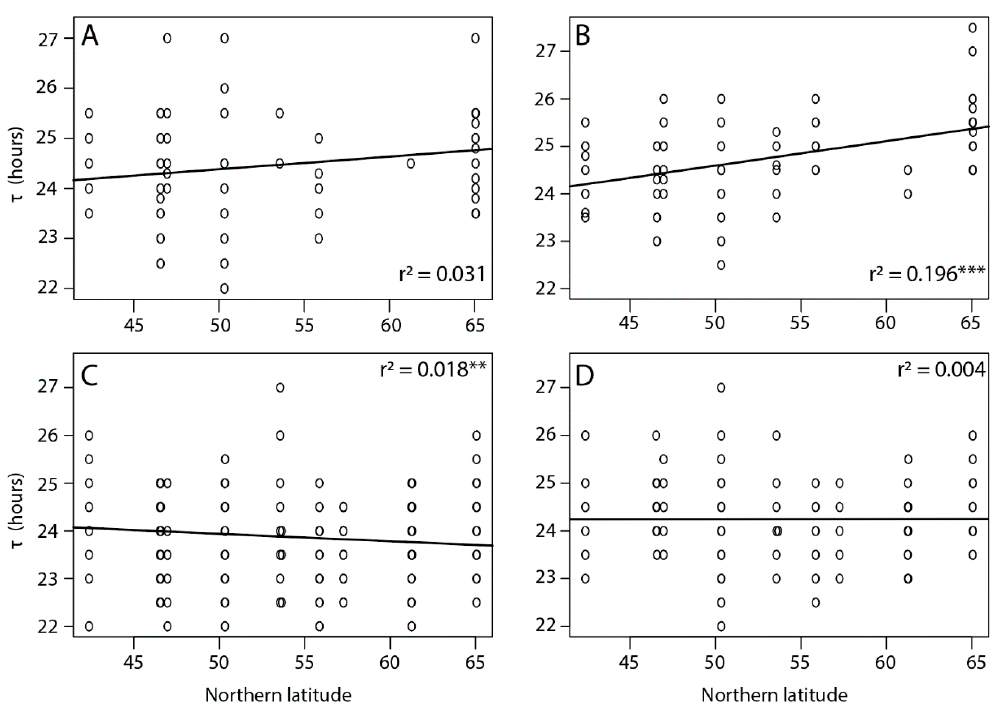
Figure 1. Proportion of rhythmic Nasonia vitripennis individuals in populations originating from seven locations in Europe in ( A ) males and ( B ) females. Locations along the x-axis are arranged from lower to higher latitude, see text for locality details. Generalized linear model (GLM) statistical analysis: effect of sex: χ 2 = 65.71, p < 0.01; effect of location χ 2 = 33.00, p < 0.01, in both females and males (effect of location: for females χ 2 = 13.28 , p < 0.05; for males χ 2 = 13.46, p < 0.05); effect of latitude: χ 2 = 1.77 , p = 0.18, in both females and males (effect of latitude: for females χ 2 = 1.65 , p = 0.19; for males χ 2 = 0.16, p = 0.68); effect of mating status within females: χ 2 = 50.25, p < 0.01; effect of mating status within males: χ 2 = 12.18, p < 0.01; effect of latitude: for virgin individuals χ 2 = 2.22, p = 0.13 and for mated individuals χ 2 = 1.60, p = 0.20. (OUL = Finland, Oulu; TUR = Finland, Turku; LAT = Latvia; HAM = Germany, Hamburg; SCH = Germany, Schlüchtern; SWI = Switzerland; COR = France, Corsica.